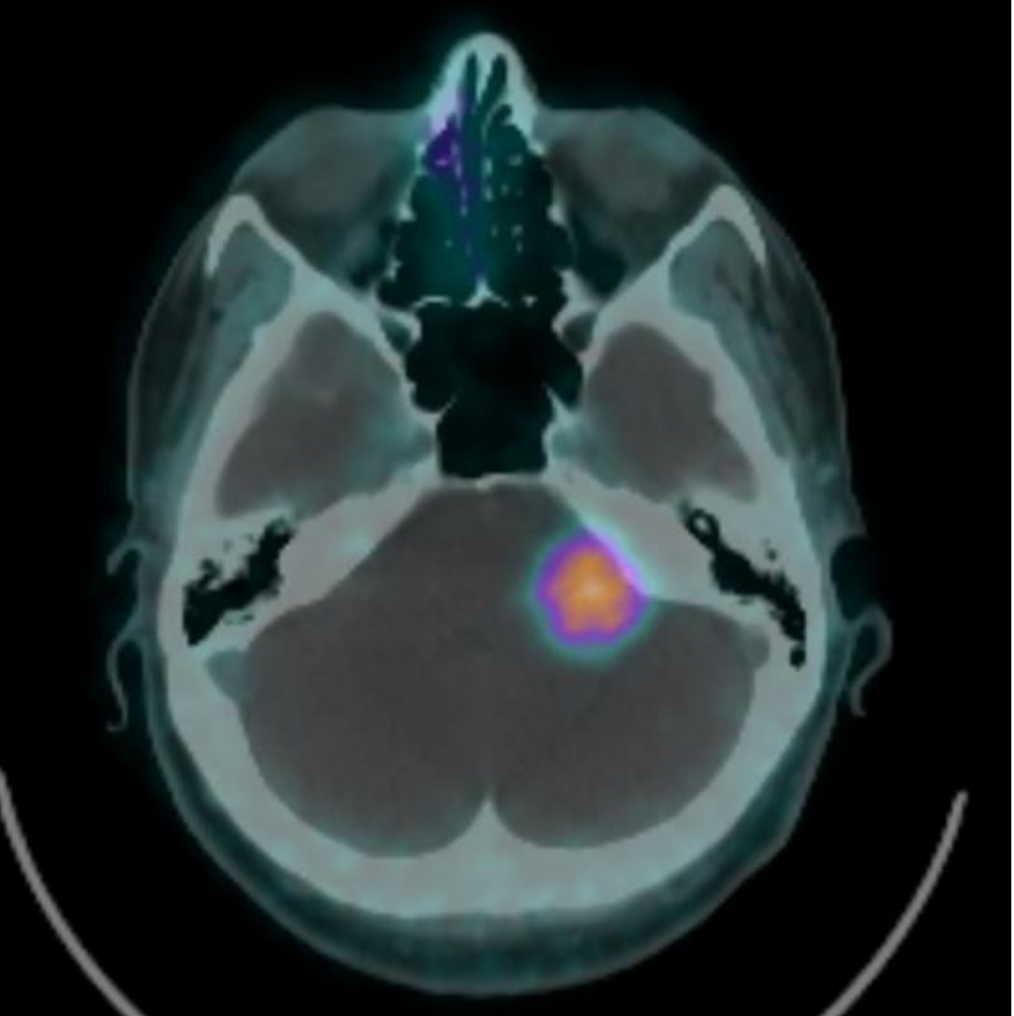
Figure 1. 68 Ga-DOTATOC positron emission tomography (PET)/CT allows differential diagnosis with caustic schwannoma. Standardized uptake value (SUV):